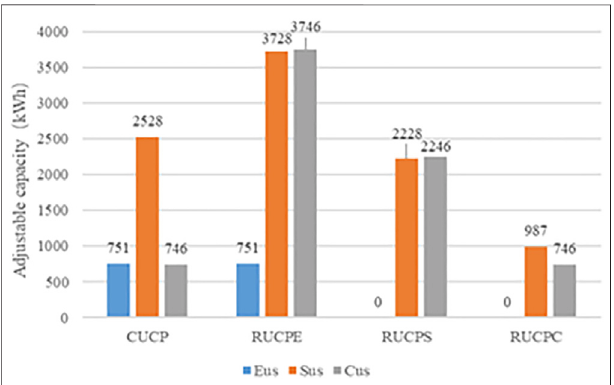
FIGURE 9 | Adjustable capacity under four scheduling